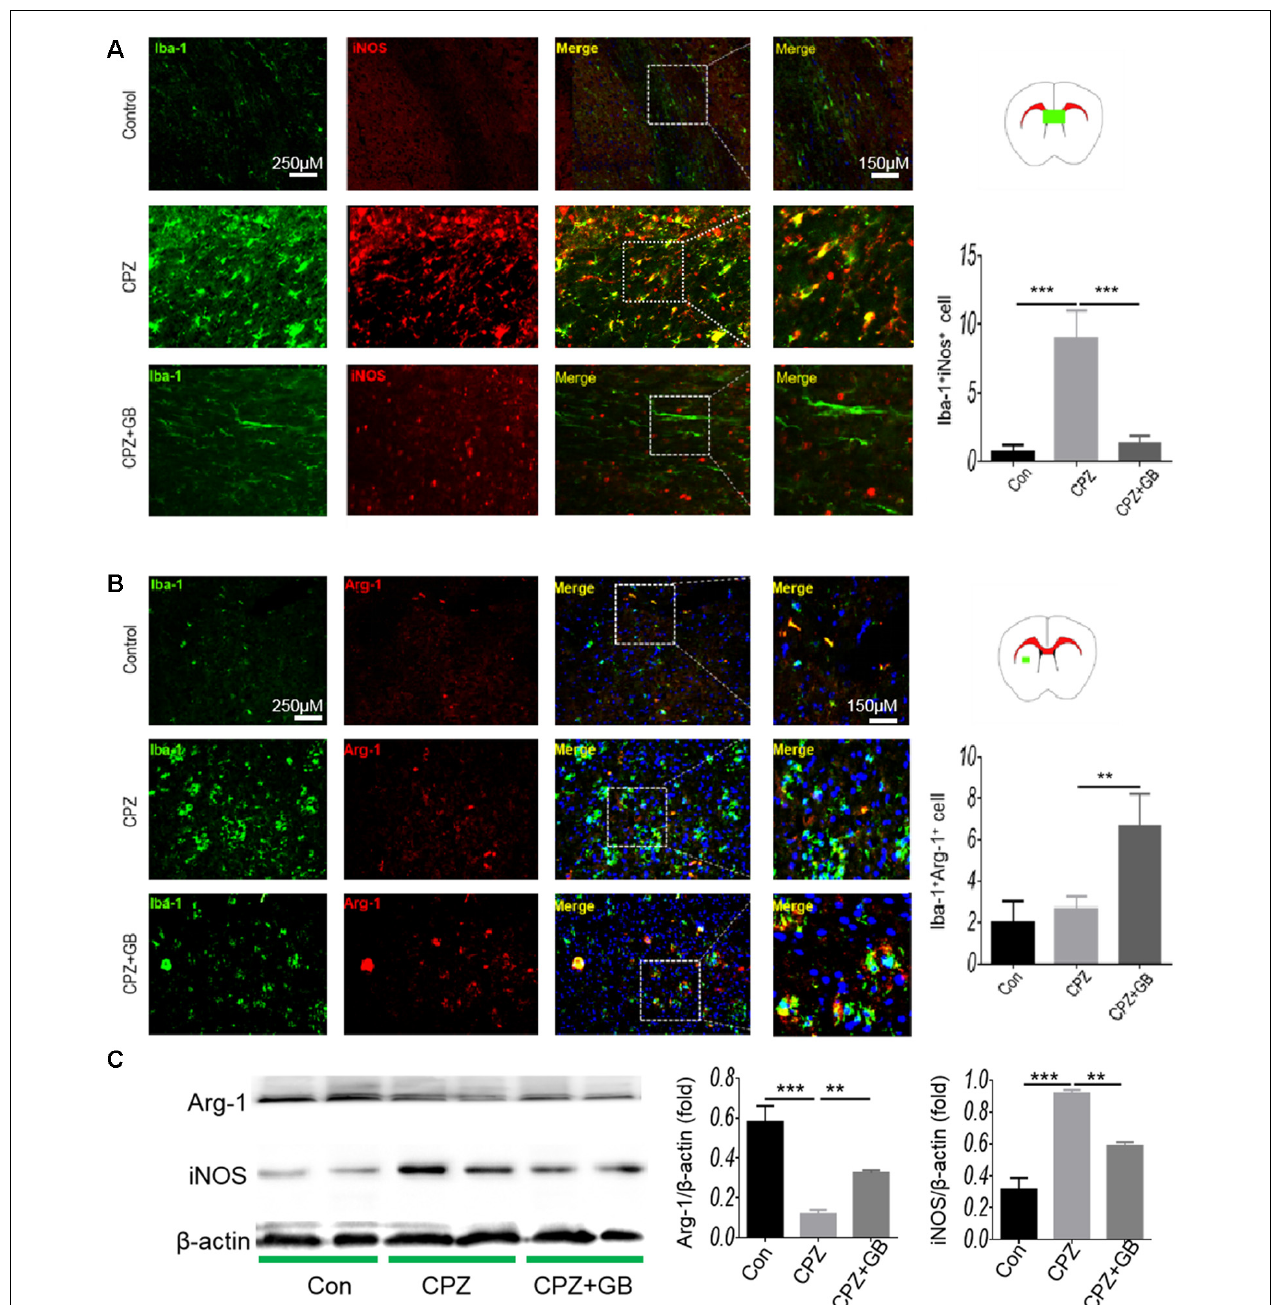
FIGURE 4 | GB influenced the phenotype of M1/M2 microglia. Mice were fed with chow containing 0.2% CPZ for 6 weeks and were intraperitoneally injected with GB for 14 consecutive days from the 4th to 6th week of CPZ feeding. (A) Double immunohistochemical staining with anti-Iba-1 and anti-iNOS in the corpus callosum, (B) double immunohistochemical staining with anti-Iba-1 and anti-Arg-1 in the striatum. (C) Expression of Arg-1 and iNOS protein in the extract of the brain by western blot. Representative images are obtained from three to four mice/each group, with similar results. The results represent the mean ± SEM. ∗∗ p < 0.01, ∗∗∗ p <